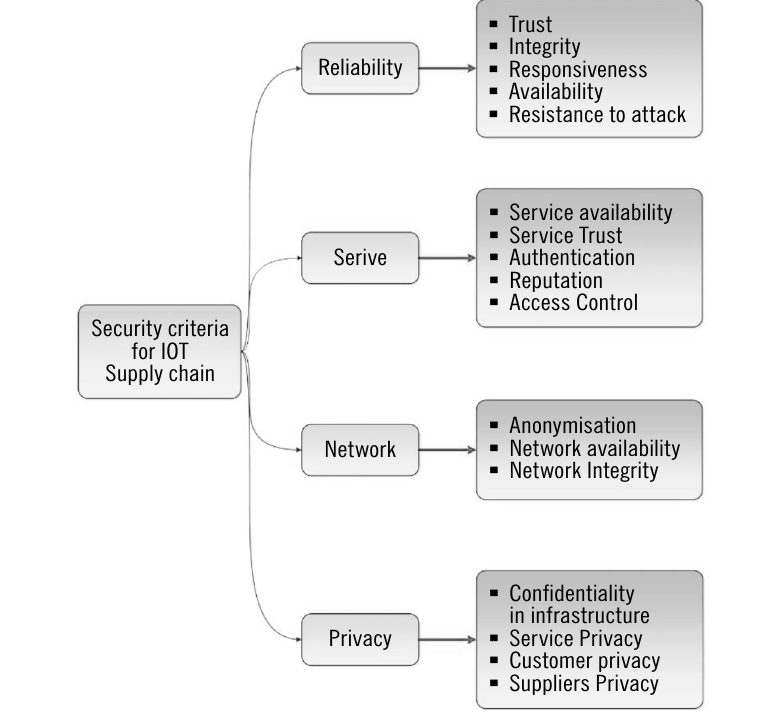
Figure 1. Security criteria in IoT supply